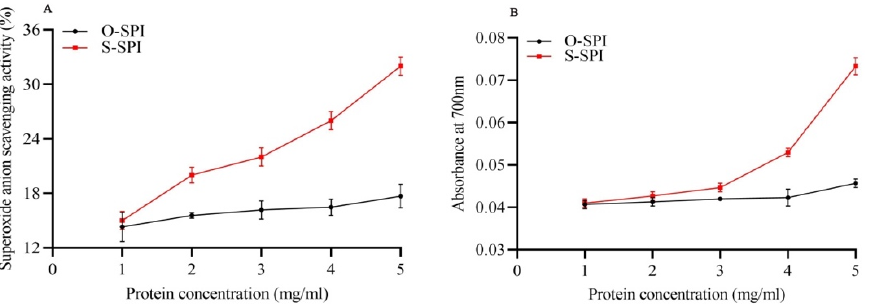
Figure 1. Superoxide anion radical scavenging ability ( A ) and reducing power ( B ) of S-SPI. Values are expressed as mean ± SEM (n = 3) , p ≤ 0.05.